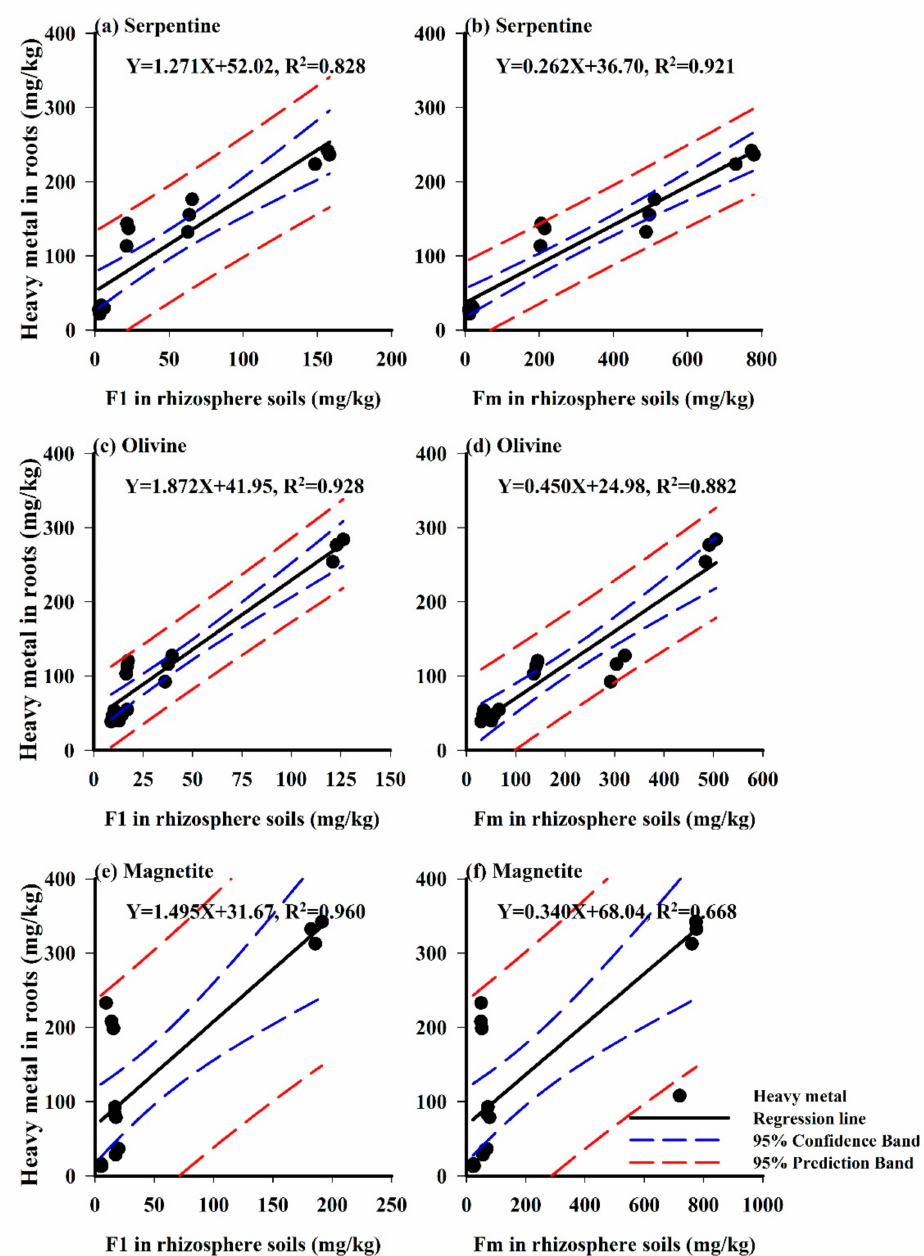
Figure 3. Diagrams of linear regression analysis between heavy metals in roots and metal fractions in three-type tailing soils. The letters ( a – f ) indicate the order of the graph for illustration in the